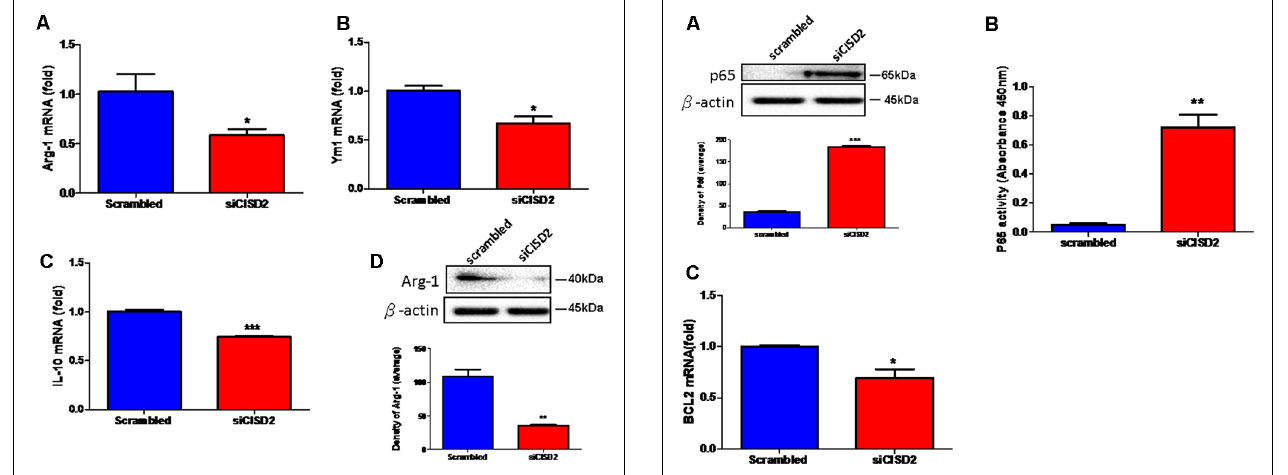
FIGURE 3 | Knockdown of CISD2 expression augmented activation of NF κ B and enhanced apoptosis in non-stressed EOC microglial cells. (A) Expression levels of p65 (total) were determined by western blot analysis ( n = 3 in each group). (B) Evaluation of P65-NF κ B DNA binding activity. The nuclear proteins were prepared, and the NF κ B DNA binding activity was analyzed by ELISA ( n = 3 in each group). (C) The extent of anti-apoptosis reflecting BCL2 mRNA expression was determined by real-time qRT-PCR. Vertical bars indicate the mean ± (SEM) of mRNA or protein expression ( n = 3). * p < 0.05; ** p < 0.01; *** p < 0.001 indicate statistically significant difference compared to scrambled control